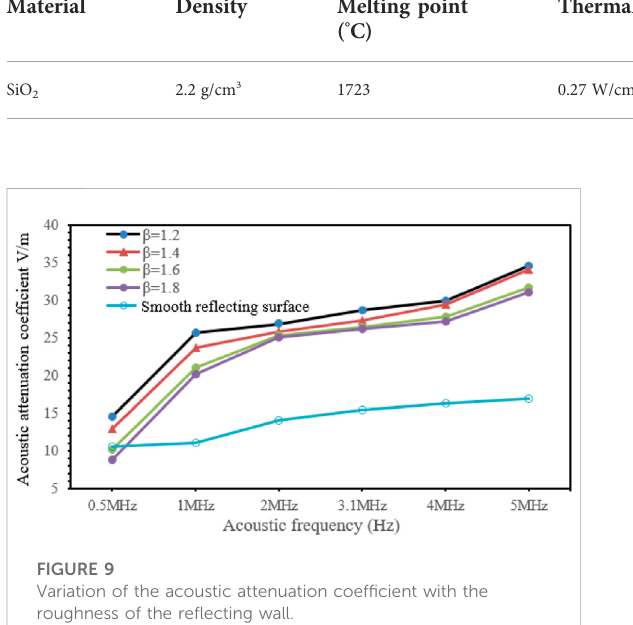
FIGURE 10 Variation of sound wave attenuation coef fi cient with diameter of insoluble